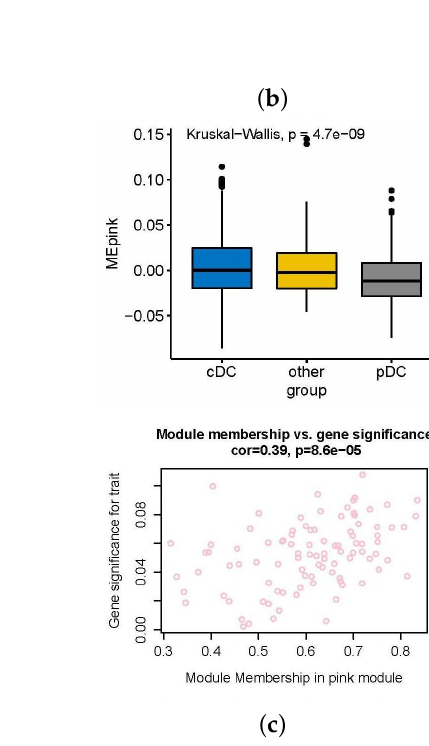
Figure 3. Correlations of gene modules with phenotypes. ( a ) Correlation heatmap of 21 gene modules with the phenotype, with the pink module being the most correlated with the phenotype. ( b ) The correlation boxplot of the pink module among the three phenotypes shows that there are significant differences in its expression. ( c ) The correlation scatterplot shows that the gene expression of the pink module and the correlation between the module and pDCs are